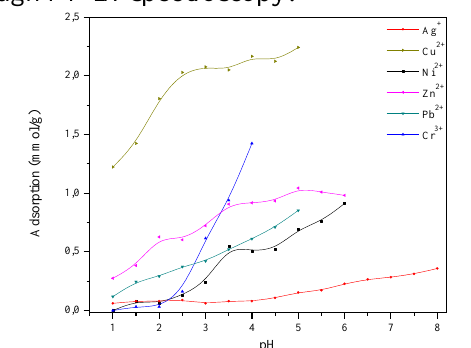
Fig. 4. Effect of pH on the adsorption of Ag + , Cu 2+ , Ni 2+ , Pb 2+ , Zn 2+ and Cr